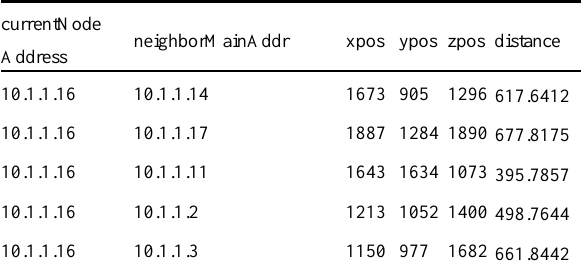
Table 4 Node n 16 and its neighbors’ three-dimensional